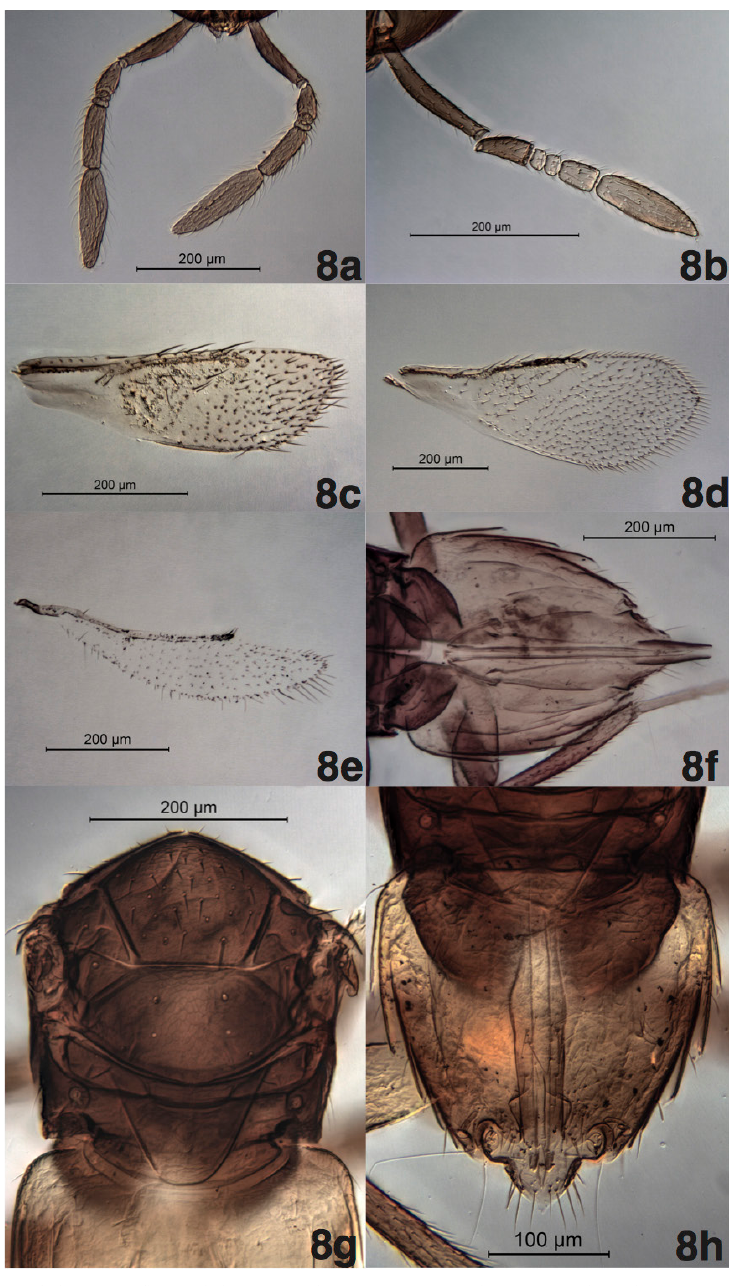
Figure 8. Aphelinus semiflavus , slide-mounted specimens 8a male, antenna, lateral view (paralectotype) 8b female, antenna, lateral view (paralectotype) 8c male, fore wing, dorsal view (paralectotype) 8d fe- male, fore wing, dorsal view (paralectotype) 8e female, hind wing, dorsal view (paralectotype) 8f fe- male, metasoma, ventral view (UCRC ENT 326827) 8g female, mesosoma, dorsal view (paralectotype) 8h male, genitalia, ventral view (UCRC ENT